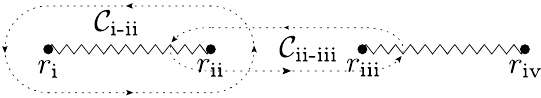
Figure 4 . The two independent contours for the same-mass elliptic